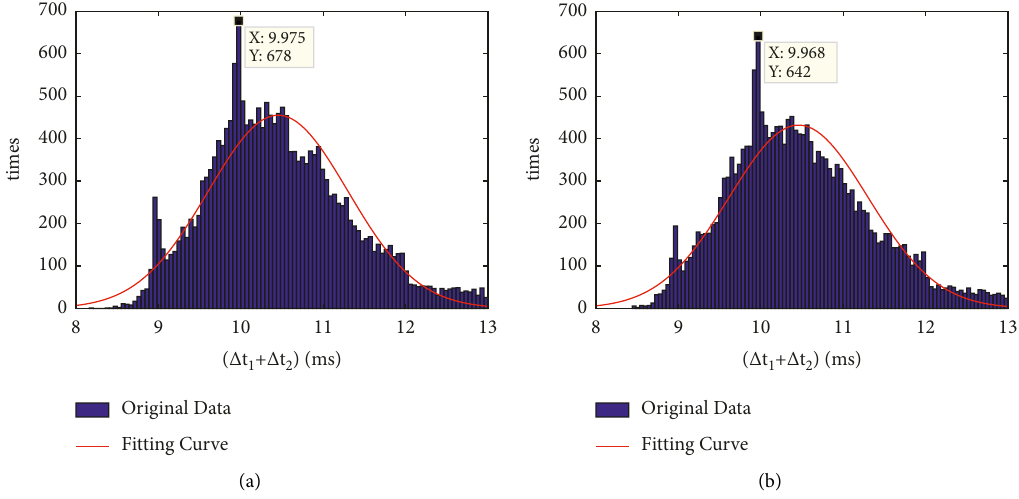
Figure 5: Distribution of 20,000 random data delays. (a) The third set. (b) The fourth